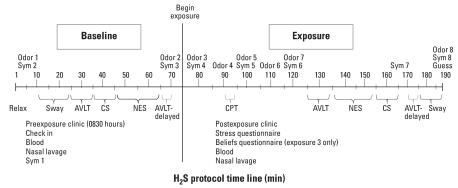
Timeline of events during each exposure session. Abbreviations: CS, contrast sensitivity vision test; Guess, exposure guess questionnaire; NES, Continuous Performance, Simple Reaction Time, Finger Tapping, Symbol Digit Substitution; Sym, symptom.